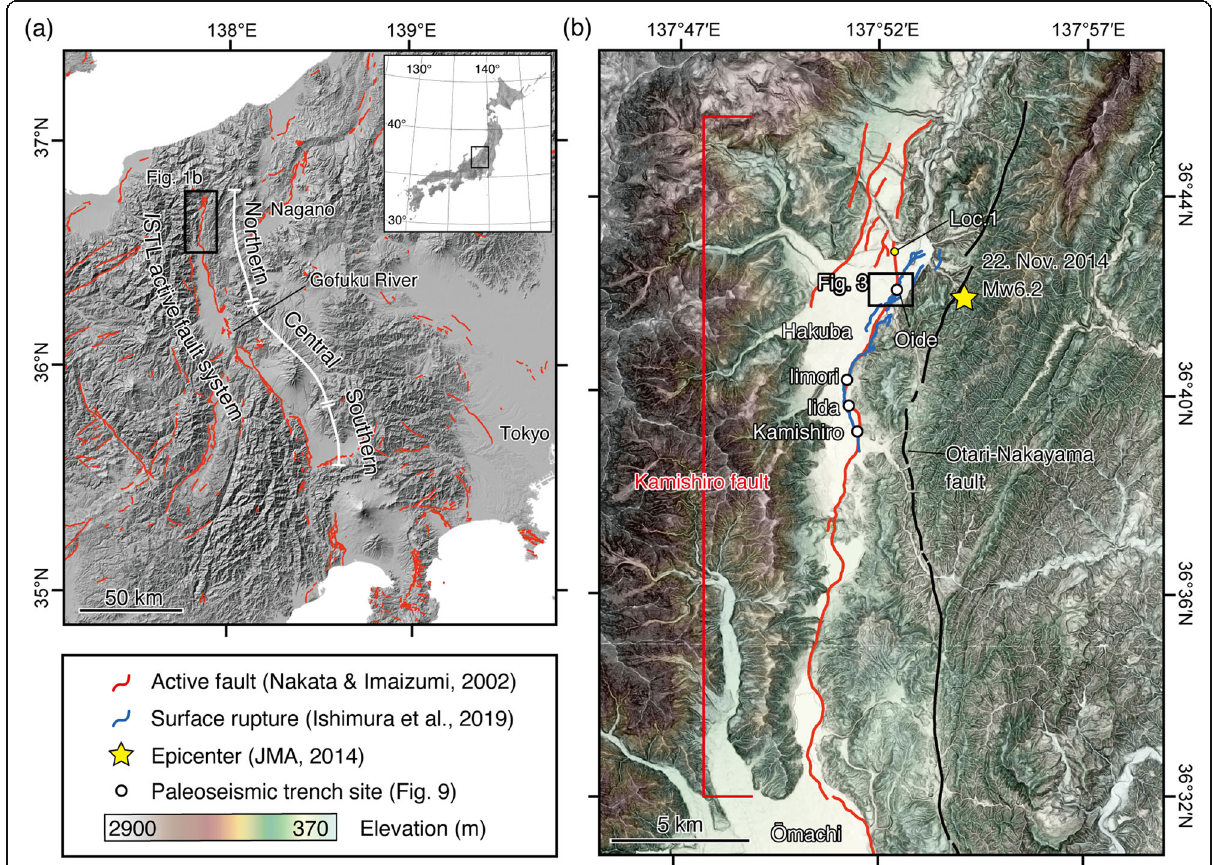
Fig. 1 Active fault map around the ISTL active fault system. a Active faults in central Japan and the ISTL composing of three major segments, each separated by change in slip direction and surface geometry of the fault trace (Nakata and Imaizumi, 2002). b The 2014 surface rupture, denoted as blue lines, occurred on approximately one-third of the previously known Kamishiro fault. The trench sites correspond with those in Fig. 10. The Otari – Nakayama fault is from Kato et al. (1989) and Nakano et al. (2002). ISTL Itoigawa – Shizuoka Tectonic Line, JMA Japan Meteorological